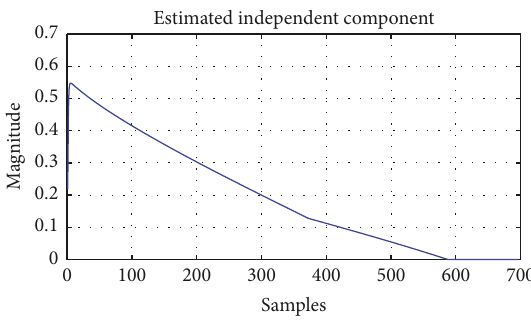
Figure 8: The estimated